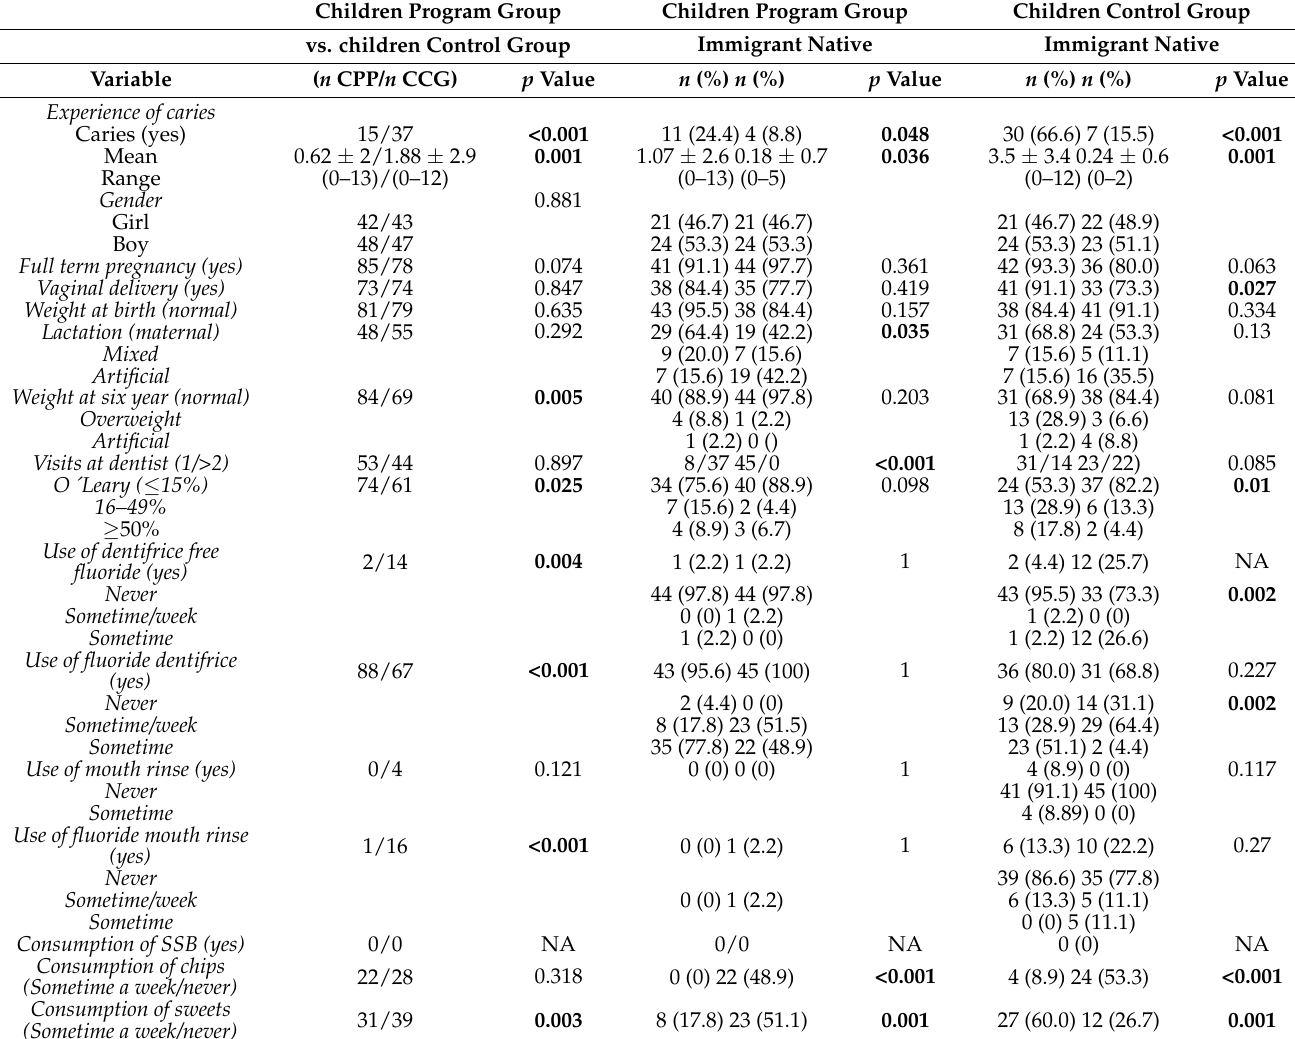
Table 2. Characteristics of the children’s variables and their relationship between the different groups: Children from oral health preventive program, children from control group. SBB sugar-sweetened beverages. NA: not applicable. In bold letters, statistically significant p -values. CPG: child program group. CCG: child control